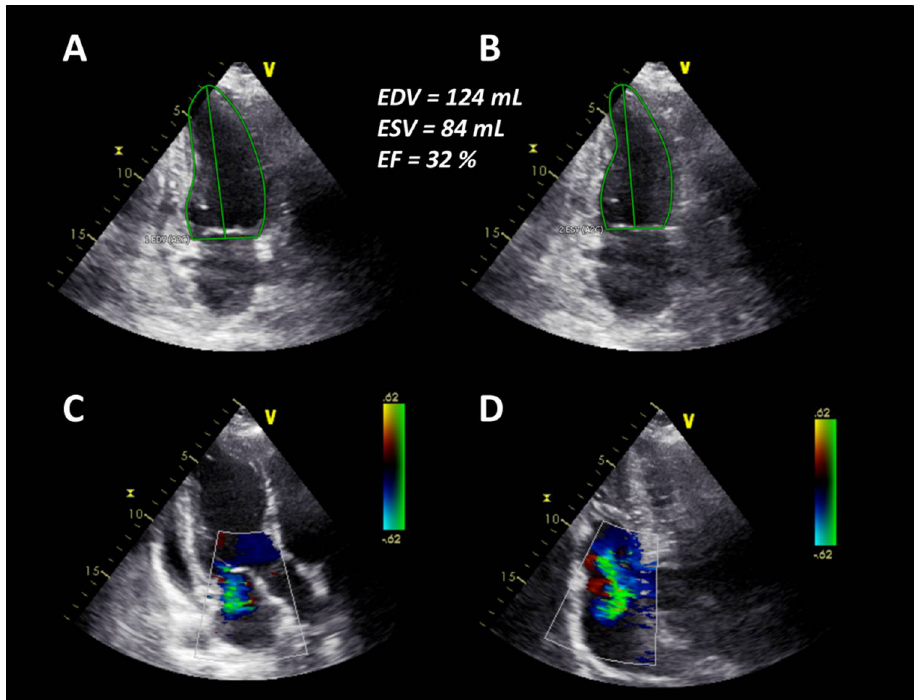
Figure 3. ( A ) End-diastolic borders of the left ventricle in the apical two-chamber view. ( B ) End- systolic borders of the left ventricle in the apical two-chamber view. ( C ) Mild to moderate mitral regurgitation in the apical three-chamber view. ( D ) Moderate tricuspid regurgitation in the apical four-chamber view.